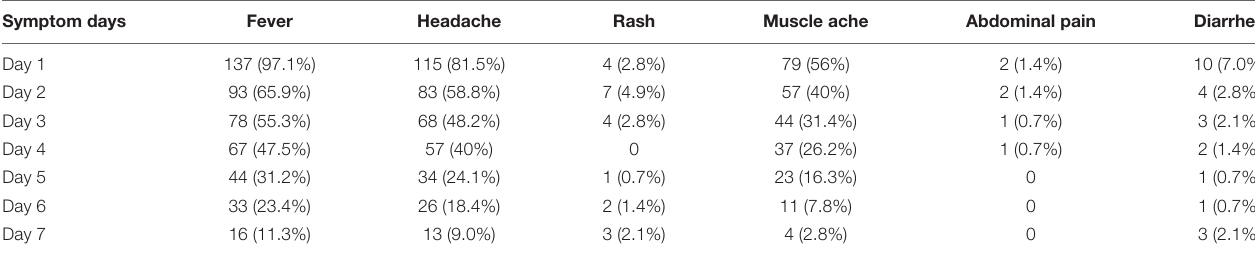
TABLE 1 | List of clinical manifestations of 141 patients with DF. Symptom